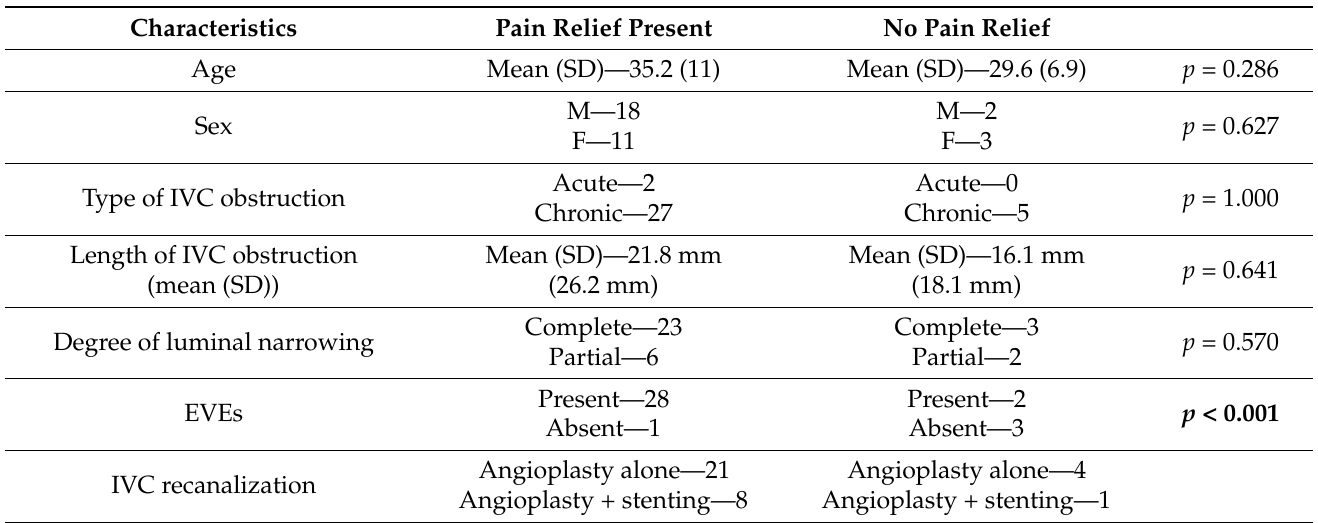
Table 3. Characteristics of patients with and without pain relief ( n = 34 patients with back